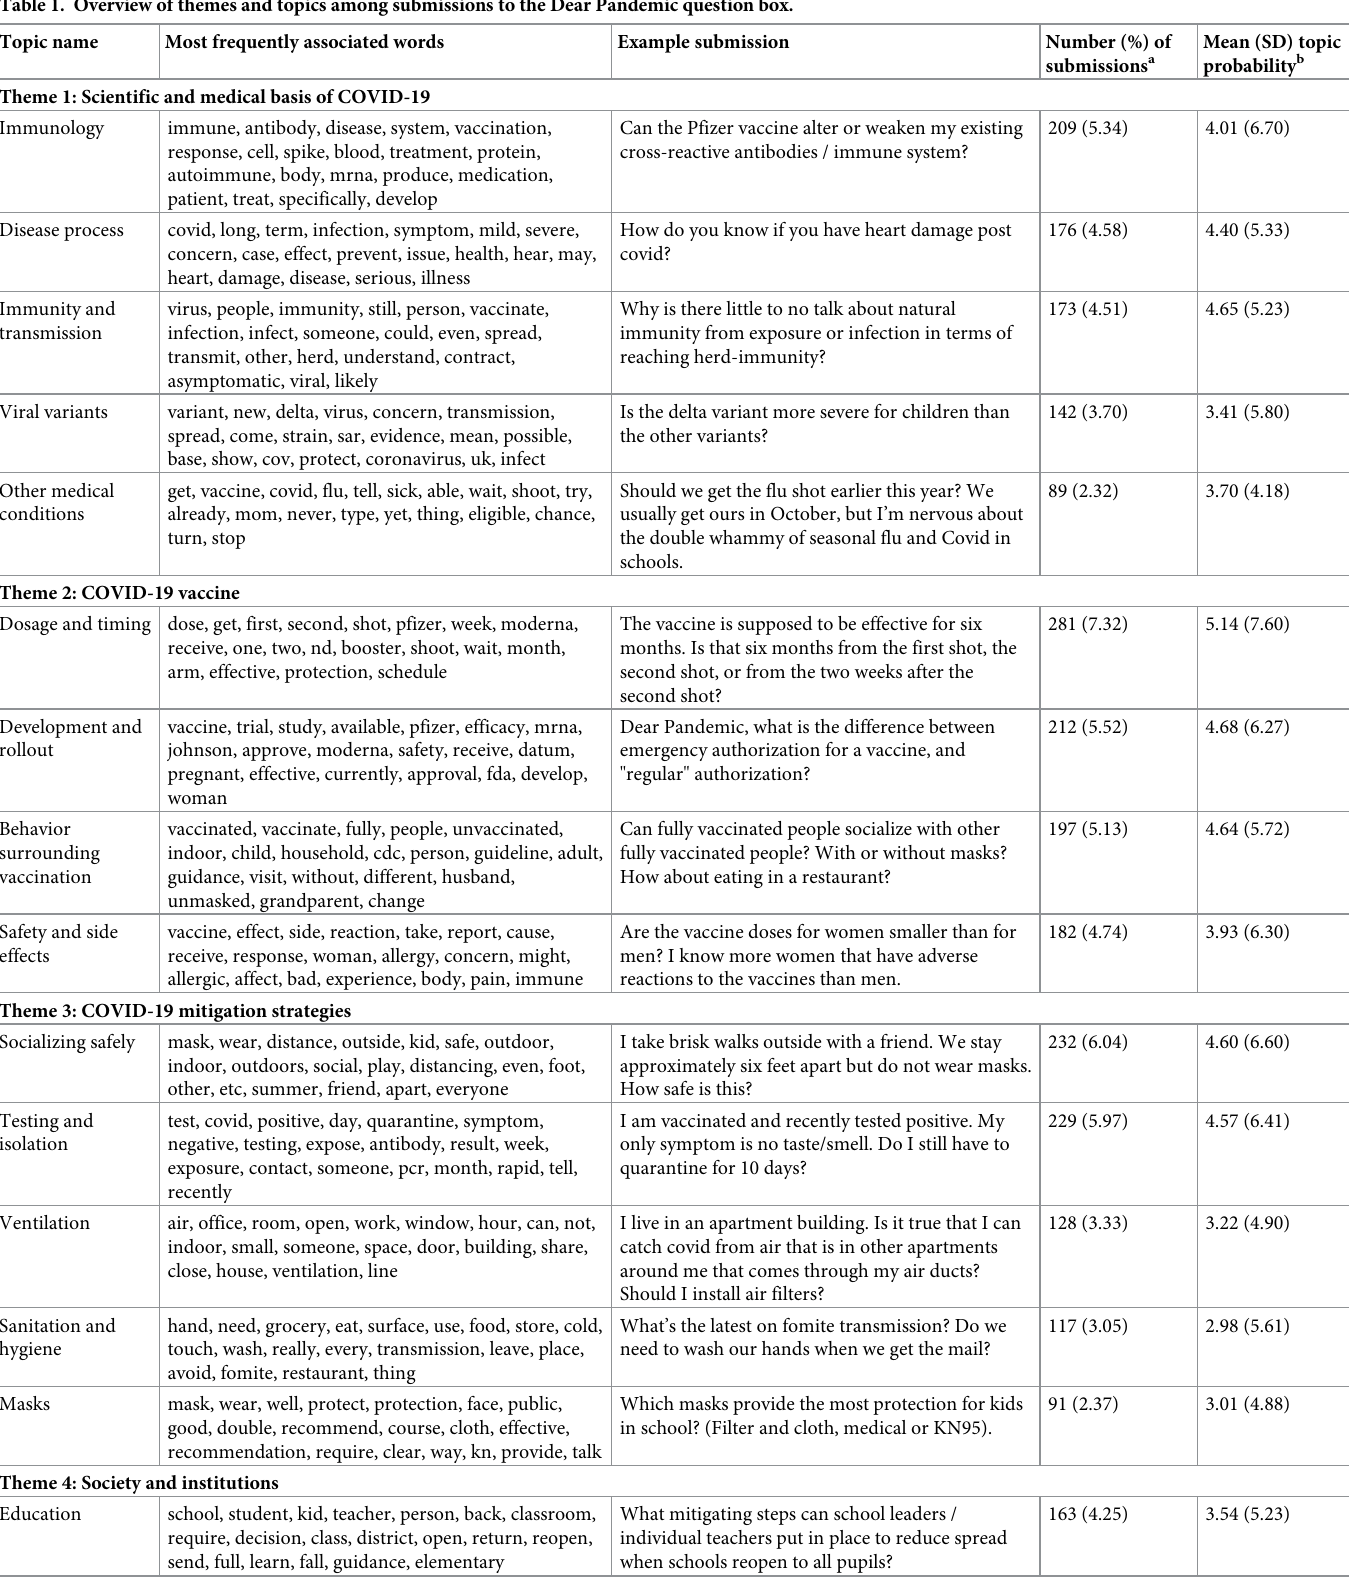
Table 1. Overview of themes and topics among submissions to the Dear Pandemic question box. Topic